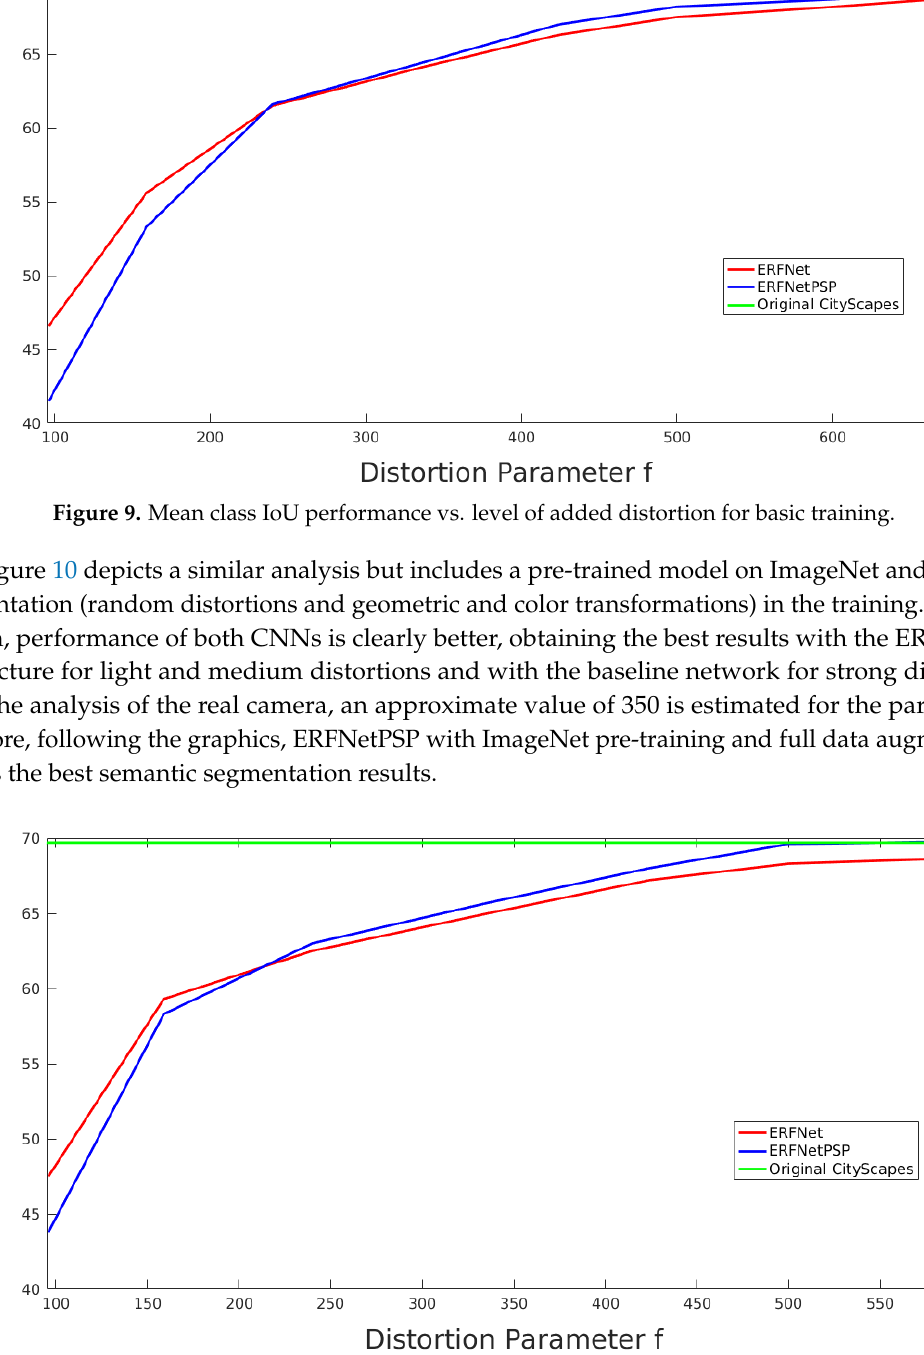
Figure 10. Results for validation subset with training with full data